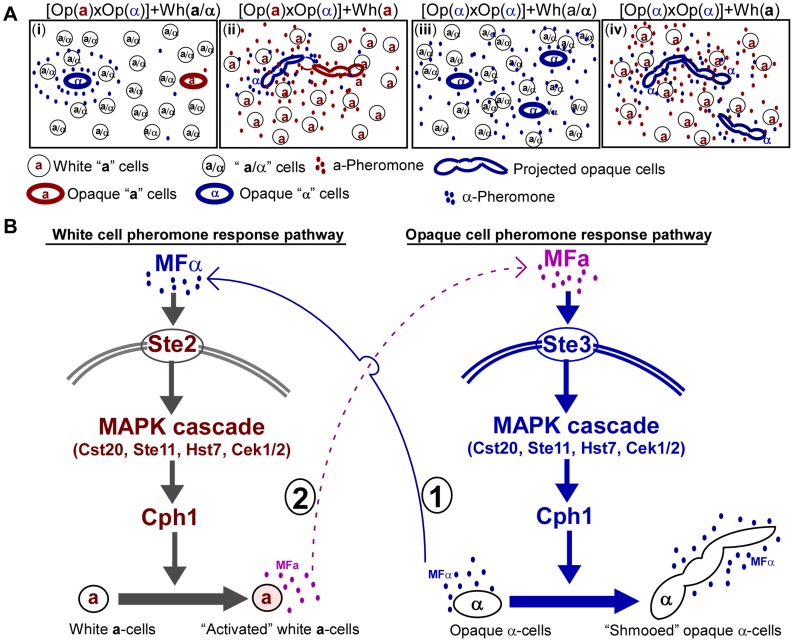
Schematic models for the role of white cells in opposite- and same-sex mating of opaque cells.(A) The majority of white cells (a) secrete pheromone to facilitate opposite- and same-sex mating of the minority opaque cells. (i) When the majority are a/α cells, sexual mating between the minority of opaque a and α cells is rare. Opaque α cells secrete α-pheromone constitutively, while opaque a cells do not secrete a-pheromone without exposure to a certain level of α-pheromone. When both opaque a and α cells are rare, the threshold for pheromone and mating responses is typically not reached. (ii) When the majority are white a cells, sexual mating between the minority opaque a and α cells can occur. Opaque α cells secrete α-pheromone and induce the majority of white a cells to secrete a-pheromone. Thus, a-pheromone in turn induces opaque α cells to form long mating projections, which facilitate them to reach opaque a mating partners. (iii) White a/α cells do not induce mating projections and do not facilitate same-sex mating of opaque α cells. (iv) White a cells facilitate same-sex mating of opaque α cells. Opaque α cells secrete α-pheromone and induce white a cells to secrete a-pheromone. In turn, a-pheromone induces opaque α cells to form mating projections and undergo same-sex mating. (B) Schematic model depicting the crosstalk between white and opaque pheromone response pathways. First, opaque α cells constitutively secrete α-pheromone and activate the white pheromone response pathway to induce a-pheromone secretion in a cells. Then, a-pheromone secreted by white a cells activates the opaque pheromone response pathway to promote mating projection formation in opaque α cells.